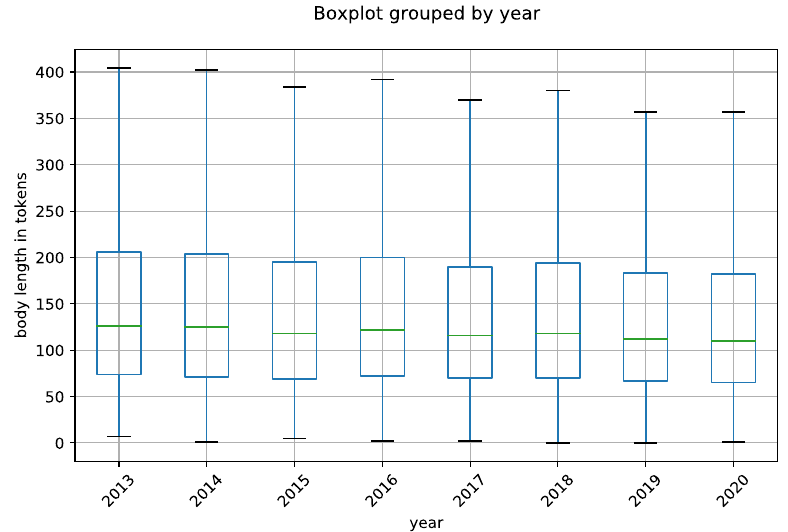
Figure A6. Distribution of the body length in tokens per year (outliers are omitted).